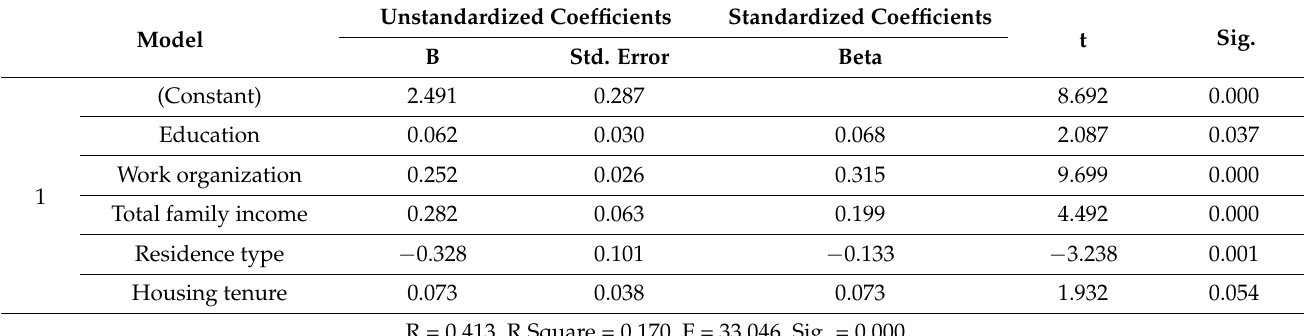
Table 6. Multiple regression of predictors of increasing water use